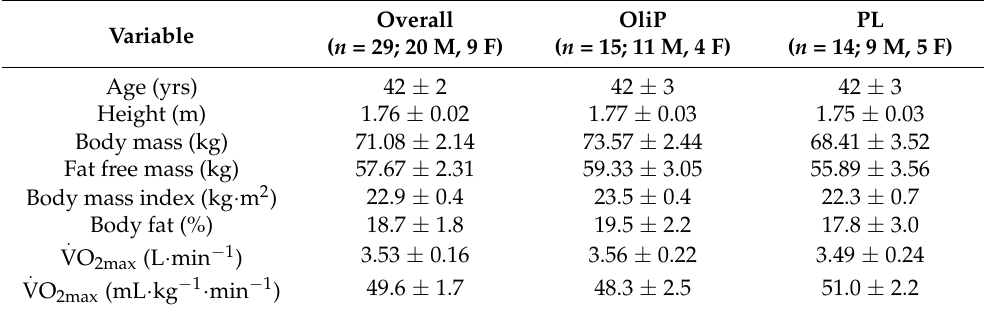
Table 1. Mean ± standard error (SE) participant characteristics overall and for OliPhenolia ® (OliP) and placebo (PL) groups